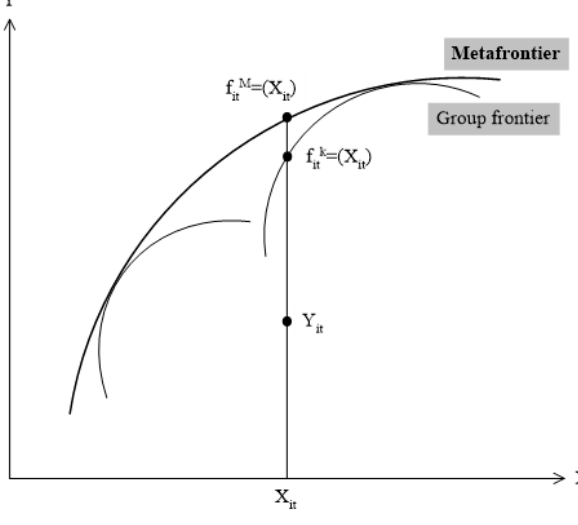
Figure 4. Metafrontier production model by